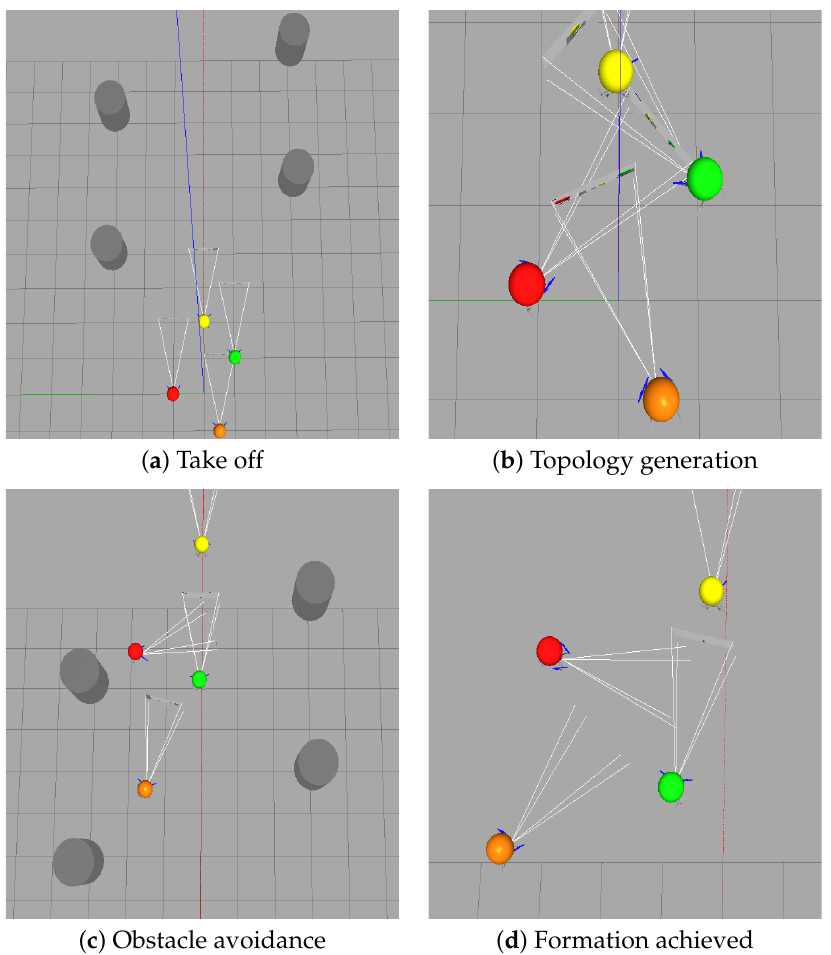
Figure 13. Four quadrotors navigate in a known environment in Gazebo. ( a ) Four quadrotors take off from the initial position. ( b ) A minimally persistent graph is generated and the quadrotors turn to the desired orientation. ( c ) Formation with obstacle avoidance. ( d ) The leader quadrotor arrives the target position, and the desired formation is